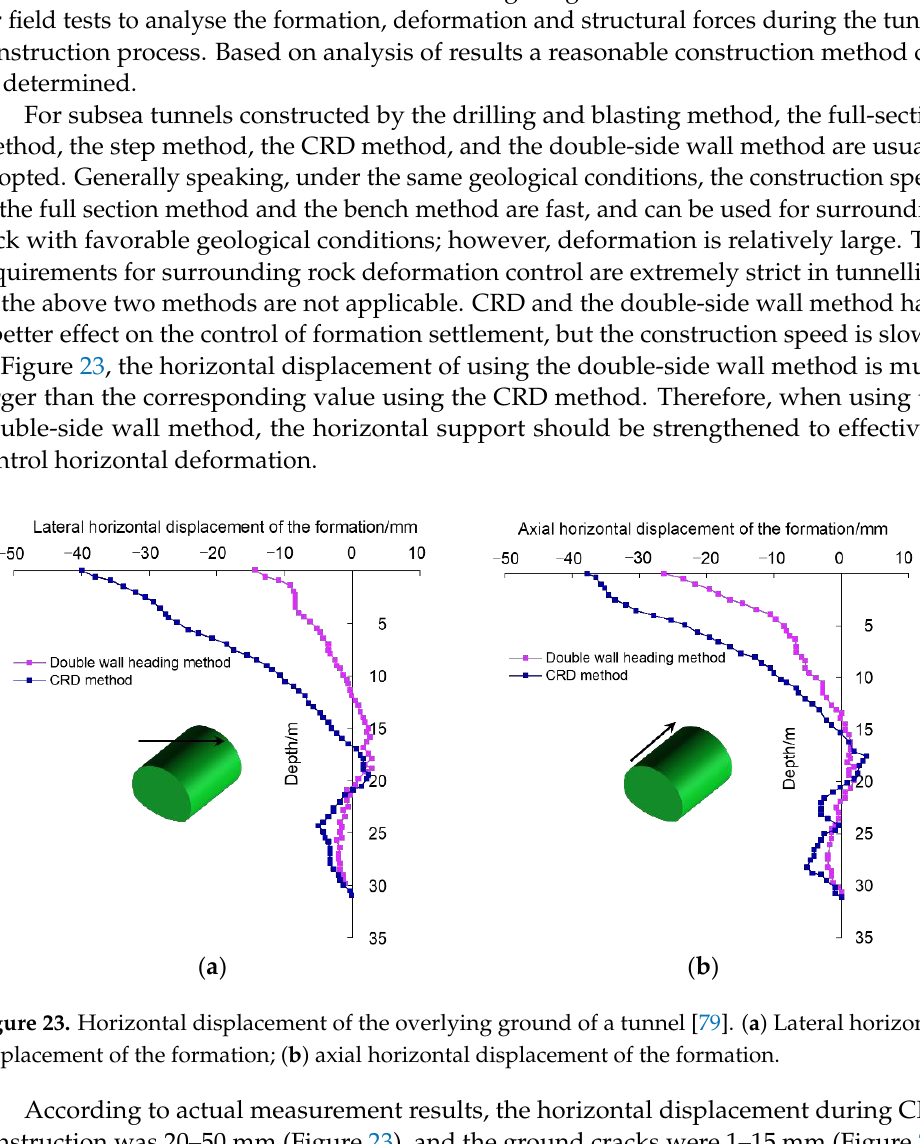
Figure 24. Surface crack propagation process curve [79]. 5.3. Advanced Geological Prediction and Field Monitoring Technology (1) Advanced geological prediction To determine the location, scale, shape and water volume of the structure in an un- excavated formation in front of a tunnel, advanced geological prediction has attracted much attention and has made great progress. Li et al. [24,155 – 161] has made outstanding contributions to the development of advanced geological prediction technology and its engineering applications. A transient electromagnetic method and ground penetrating ra- dar are sensitive to water bearing geological structures, but they may be disturbed by the complex electromagnetic environment of the tunnel. At present, the transient 5